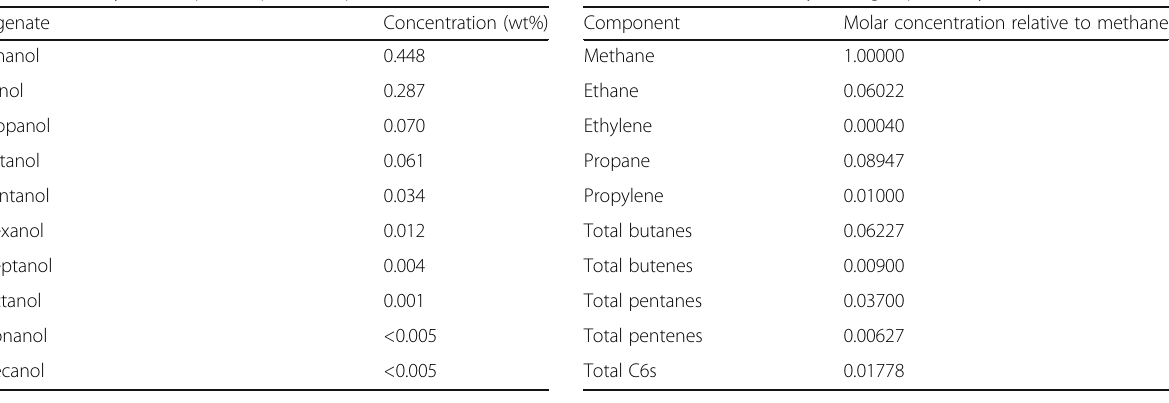
Table 3 On-line GC analysis of gas phase